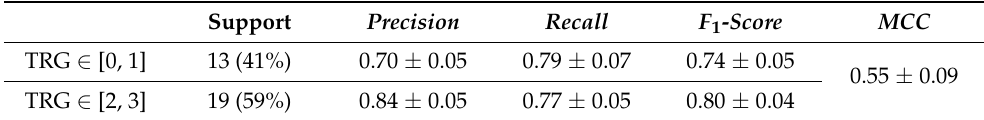
correlation coefficient ( MCC ) is reported in the last